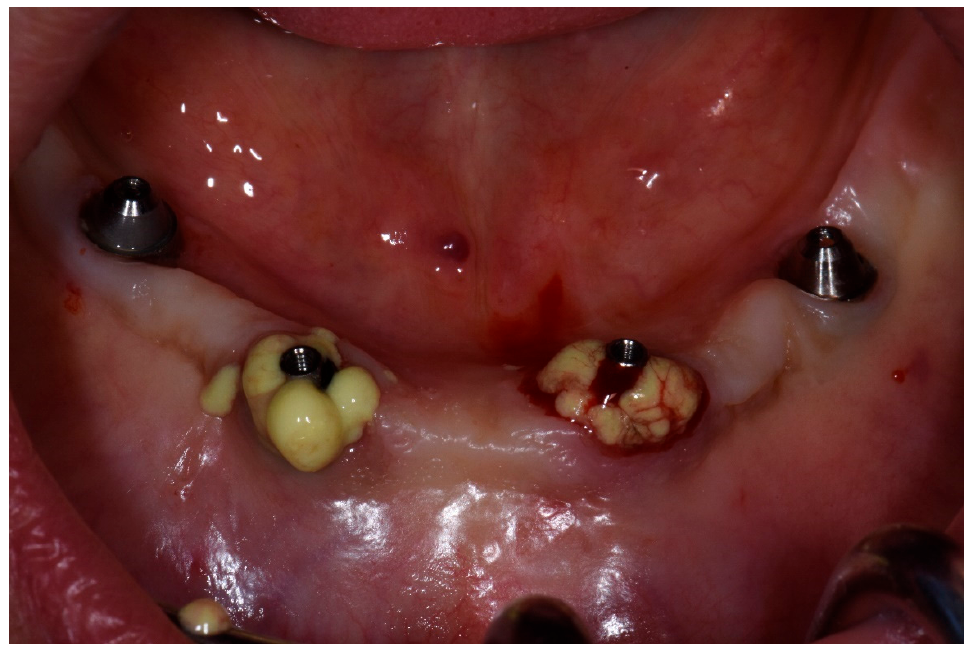
Figure 3. Application of antibiotics with special device around dental implants in positions 3.2 and 4.2.